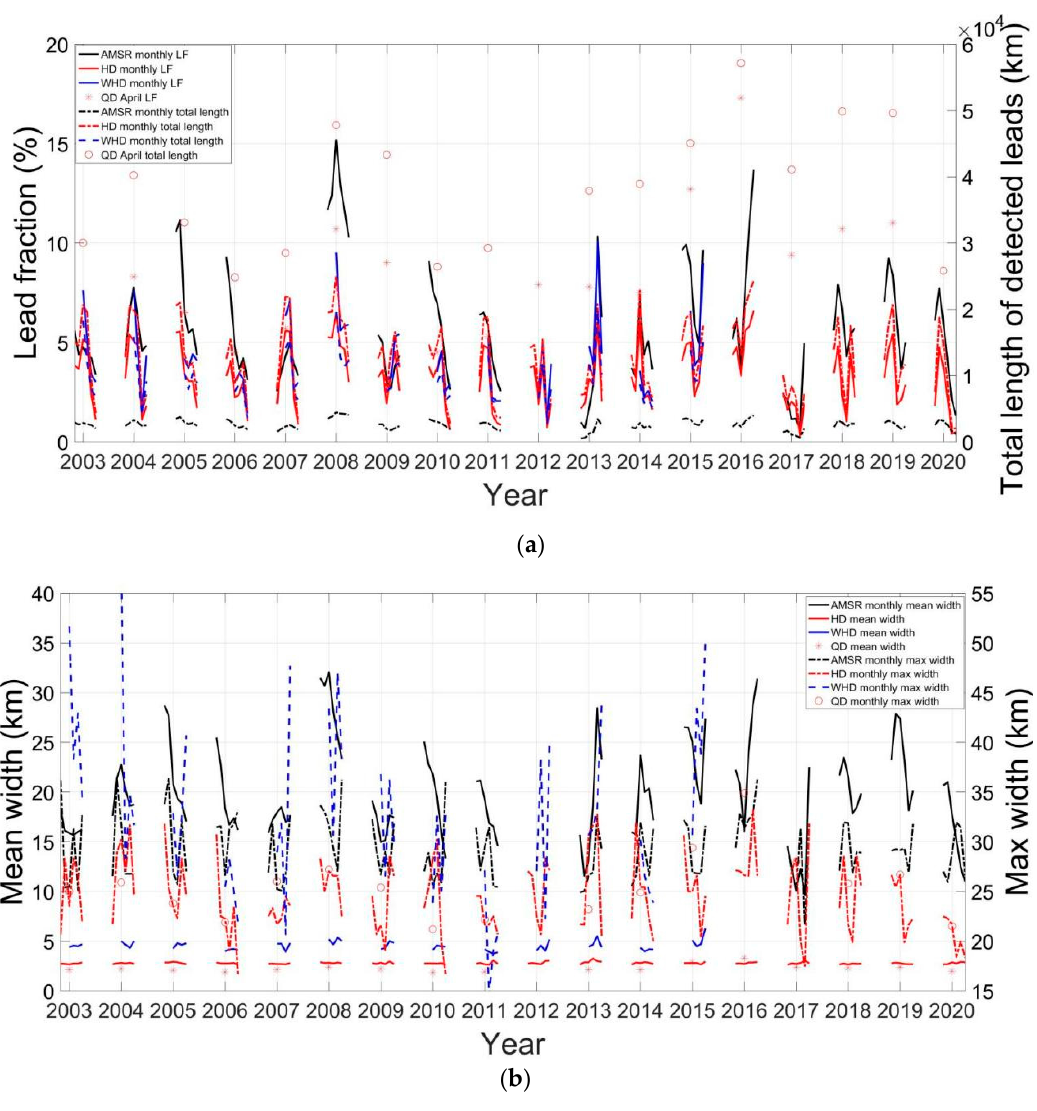
Figure 9. Evolution of sea ice lead ( a ) fraction, total length, ( b ) mean width, and max width in the Beaufort Sea. The solid lines and * in ( a ) denote lead fraction. The dashed lines and circle in ( a ) denote total length of sea ice leads. The solid lines and * in ( b ) denote lead mean width. The dashed lines and circle in ( b ) denote lead max width. The black, red, and blue lines denote the AMSR, HD, and WHD products, respectively. The masks denote the QD product. The WHD product is available 2003–2015. Units for total length, max width, and mean width of sea ice leads are km.